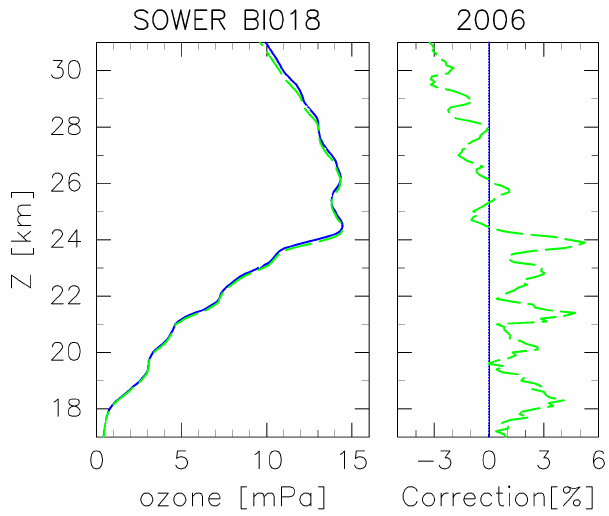
Figure B1. (Left) Profile of ozone partial pressure measured with- out a GPS unit at 22:18 on 13 January 2006 (UT) (blue line) and that recalculated with corrected pressure by subtracting the pres- sure bias shown in Fig. 2 from the original value (green dashed line). (Right) Percentage of correction amount due to the pressure correction (green dashed